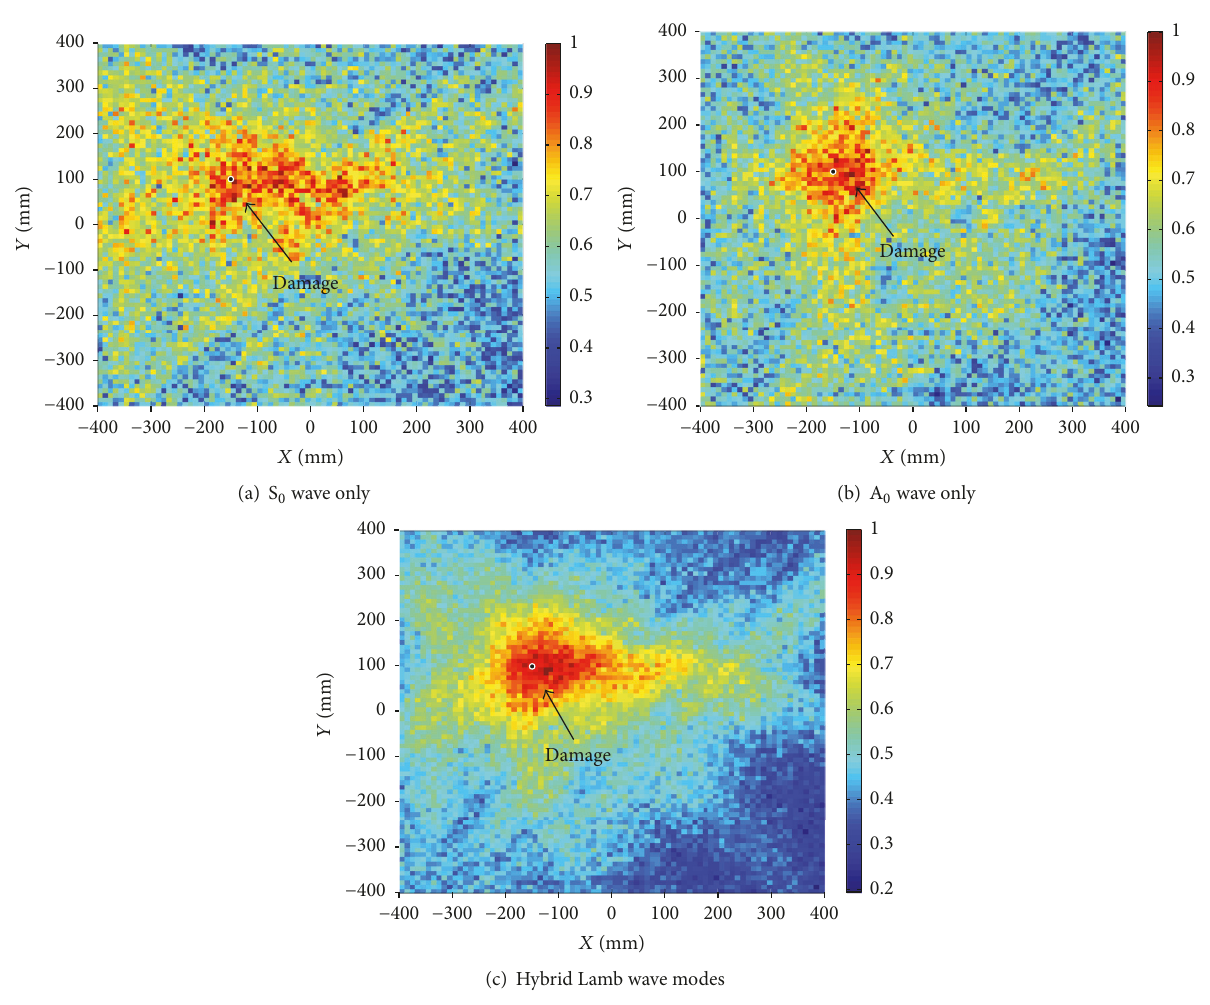
Figure 14: Comparison of damage maps